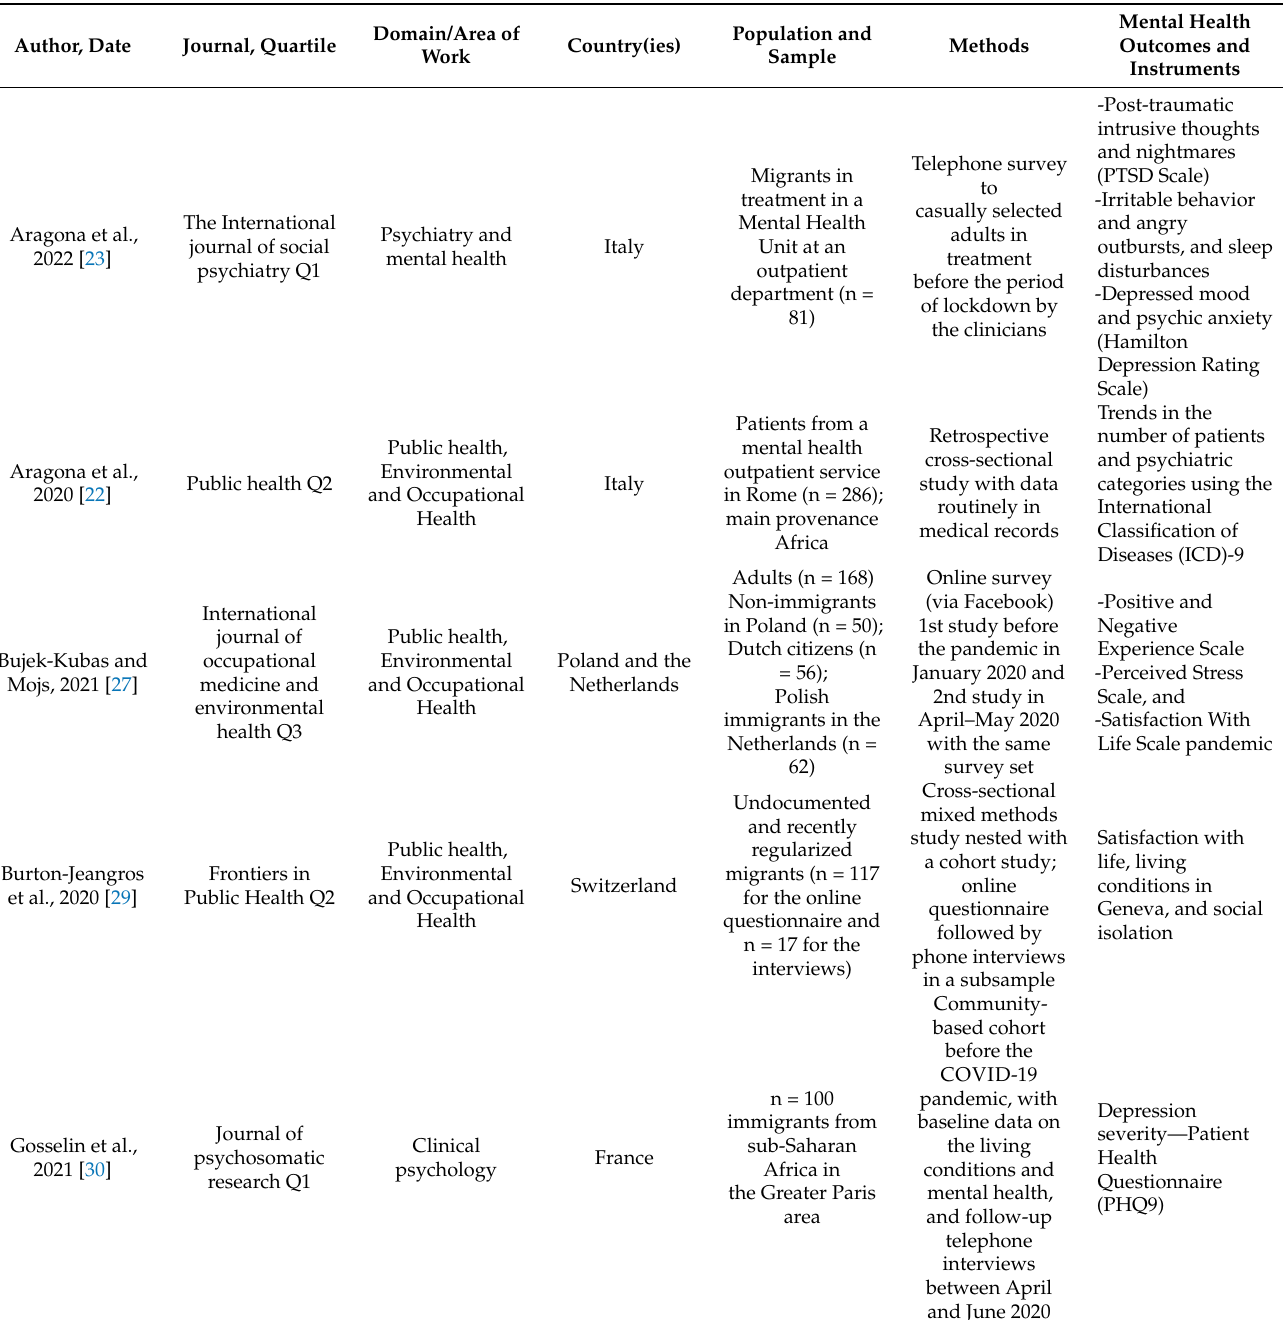
Table 1. Characteristics of the